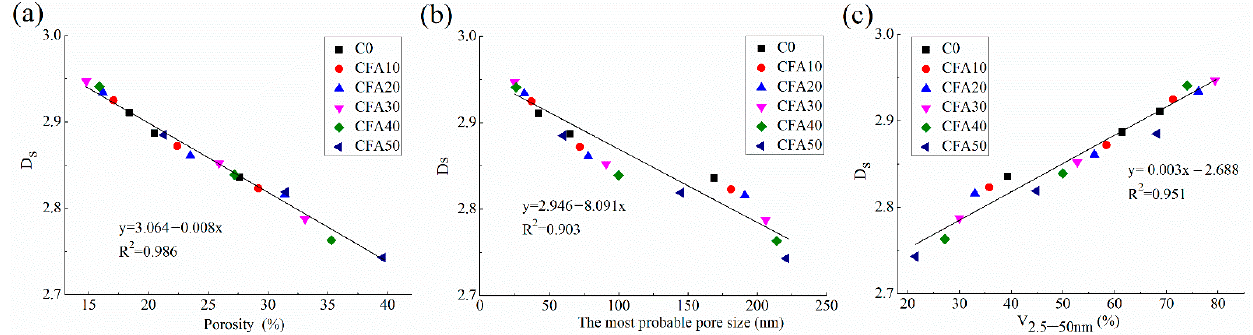
Figure 2. Relationship between D s and ( a ) porosity, ( b ) the most probable pore size and ( c ) V 2.5 – 50 nm.